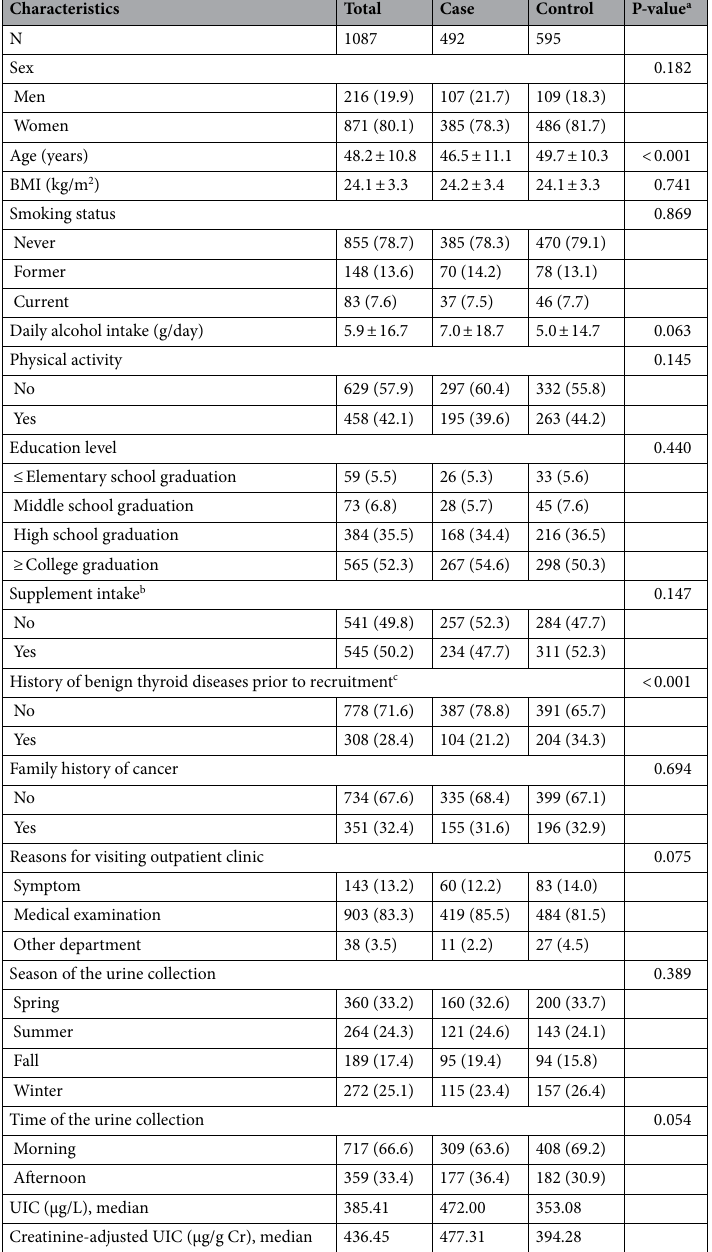
Table 1. Characteristics of the 492 case patients with PTC and 595 control patients with benign thyroid diseases at Samsung Medical Center (SMC) in South Korea between 2011 and 2016. UIC urinary iodine concentration. Values are mean ± SD or n (%). a P values were derived from a chi-square test for categorical variables and from t-test for continuous variables. b Supplement intake includes multiple vitamin, vitamin C, vitamin E, vitamin D, calcium, omega-3, red ginseng. c History of benign thyroid diseases prior to recruitment include thyroid nodule or benign tumor, hypothyroidism, hyperthyroidism, goiter,